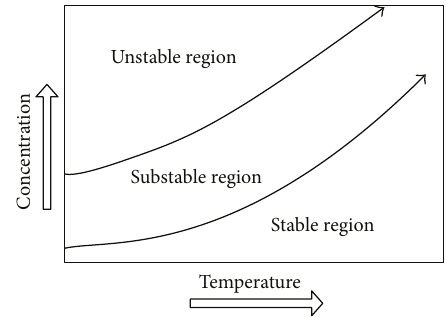
Figure 4: Supersaturation and super solubility curves of the solution.